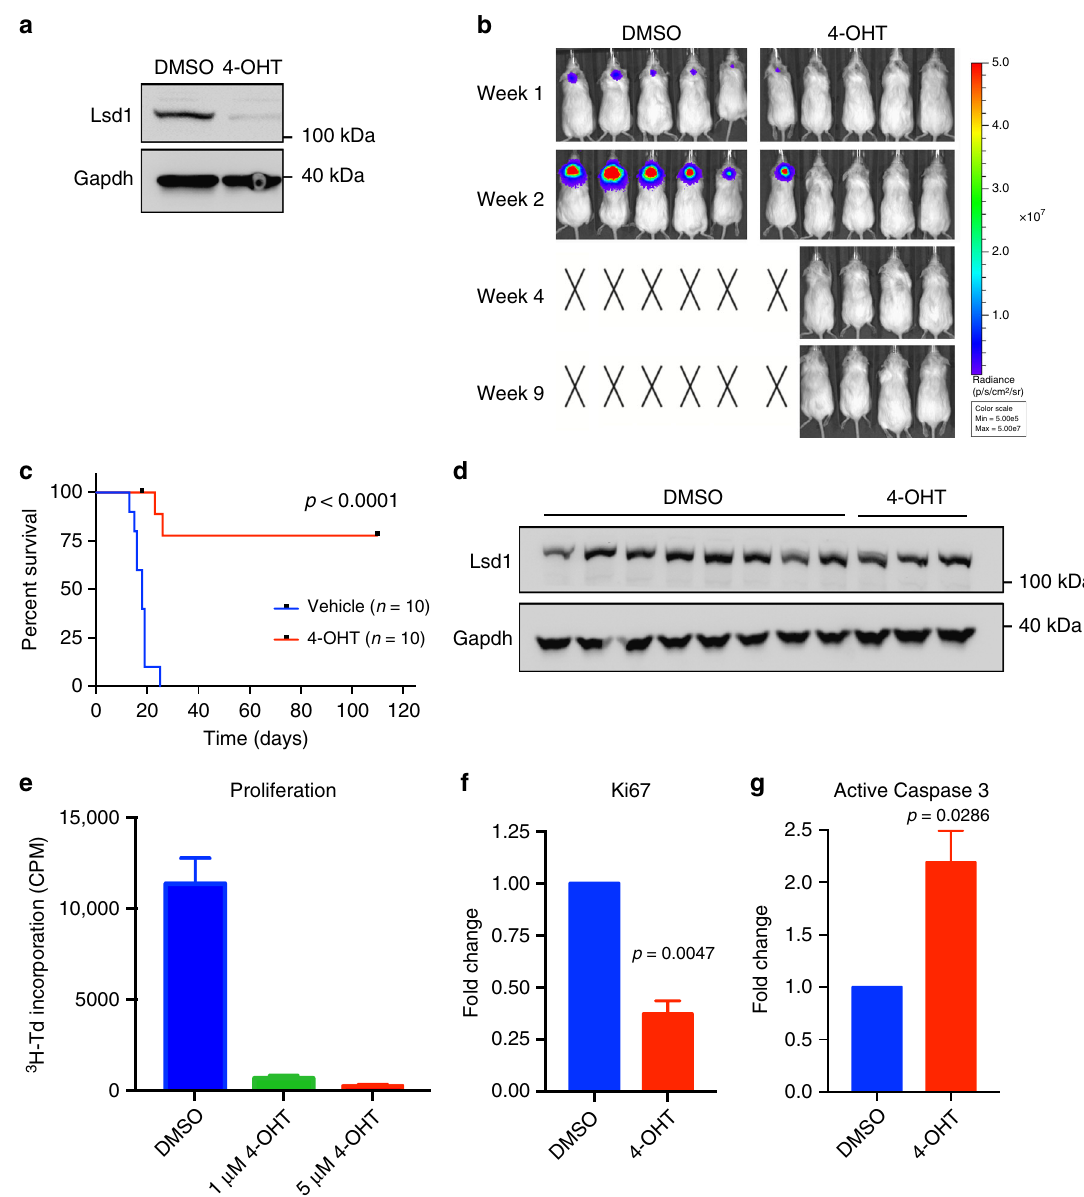
Fig. 4 Genetic deletion of Lsd1 impairs growth of G fi 1-driven MB. a Western blot for Lsd1 protein in Lsd1-iKO tumor cells that were treated overnight